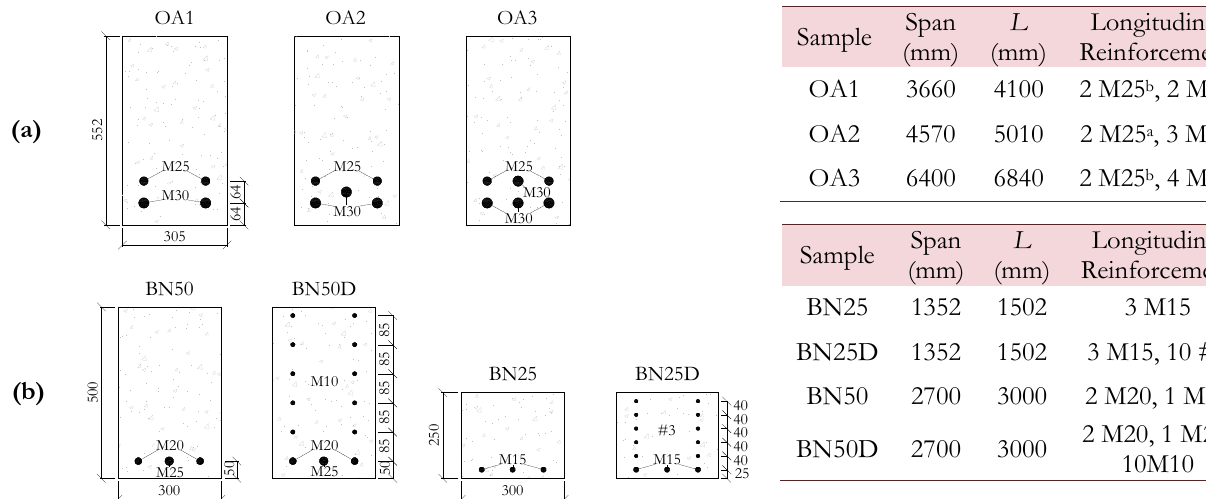
Figure 2: Geometric dimensions (in mm) and reinforcement arrangement of the analyzed beams: (a) OA [17] and (b) BN series